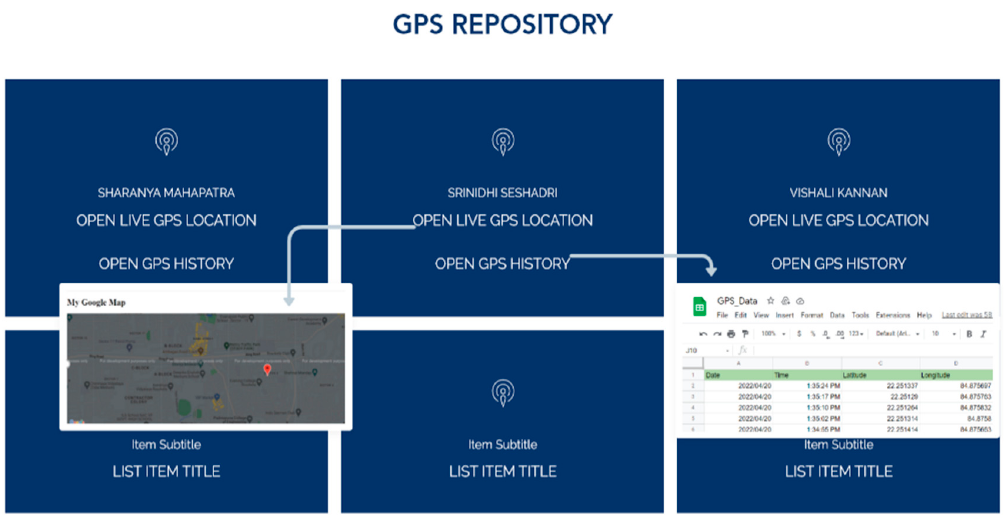
Figure A6. Respective links for GPS history and live location .